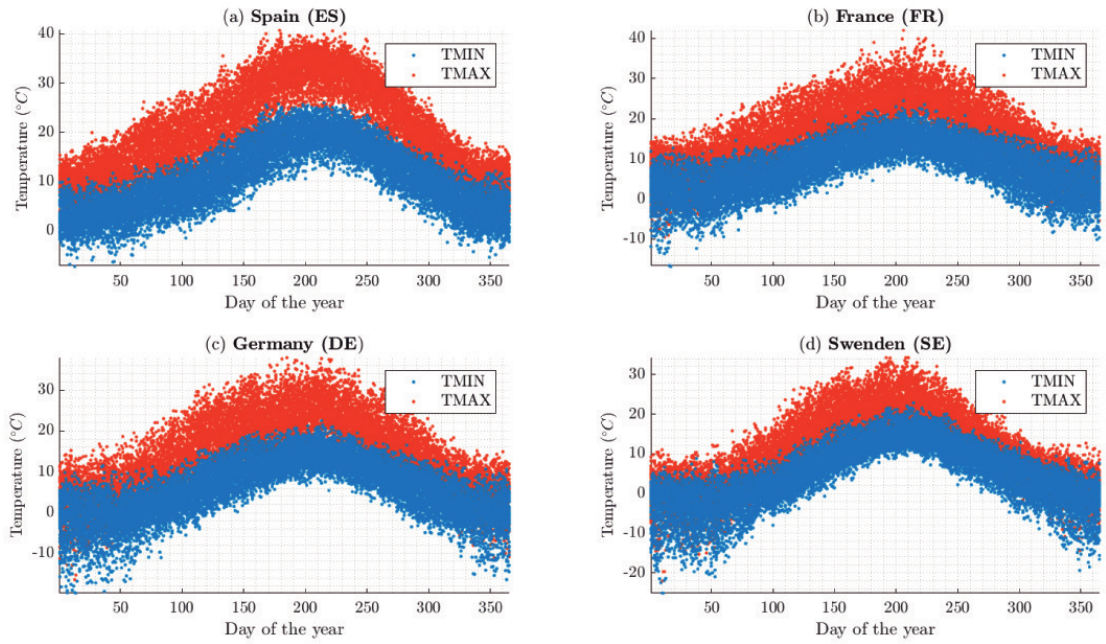
Figure 2. Seasonal plots where the daily data from each year are overlapped: ( a ) Spain (ES). ( b ) France (FR). ( c ) Germany (DE). ( d ) Sweden